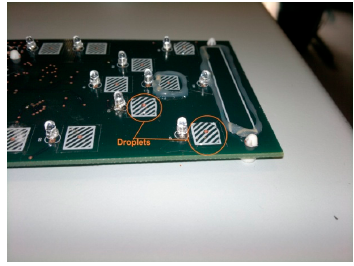
Figure A2. Self-capacitance.